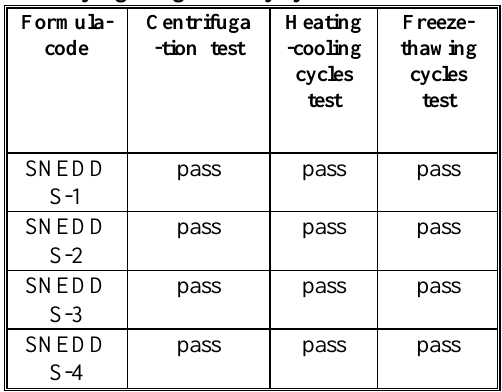
Table 4. Thermodynamic stability studies of bromocriptine mesylate liquid self-nano emulsifying drug delivery systems .